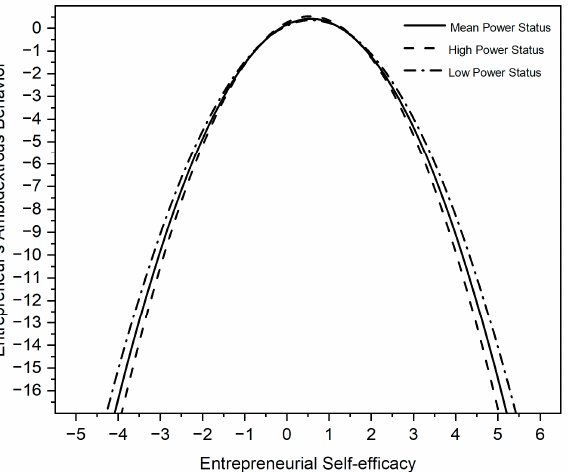
Figure 3. Moderating effects of power status on self-efficacy and entrepreneurs’ ambidextrous be- haviour.